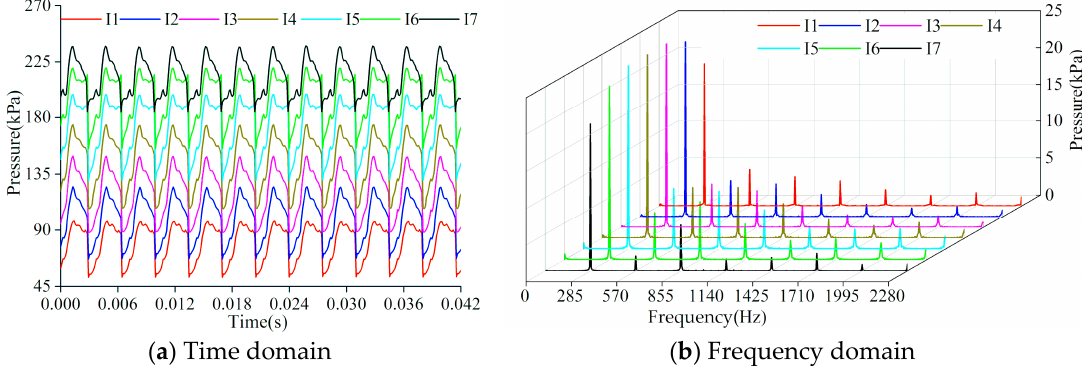
Figure 16. The time and frequency domain diagrams of pressure fluctuation for the monitoring points at the middle streamline of a single impeller channel when the monitoring points are stationary relative to the fixed coordinate system.